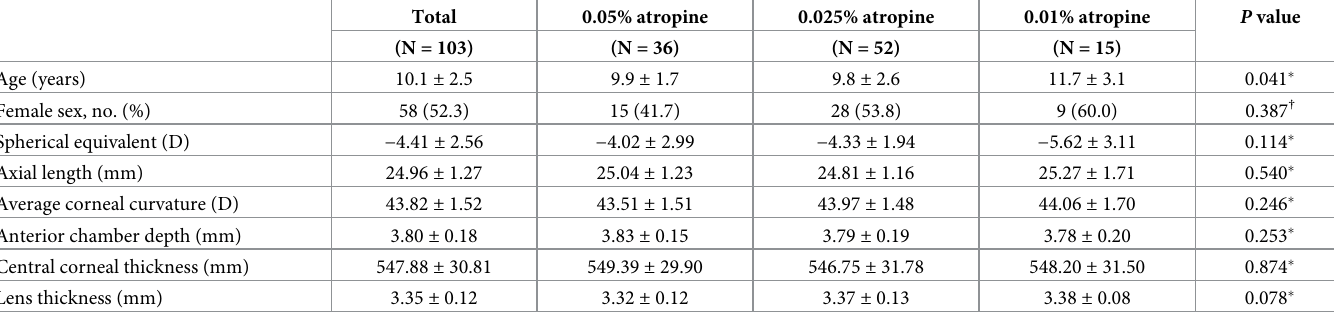
Table 1. Baseline demographic characteristics and ocular parameters of study